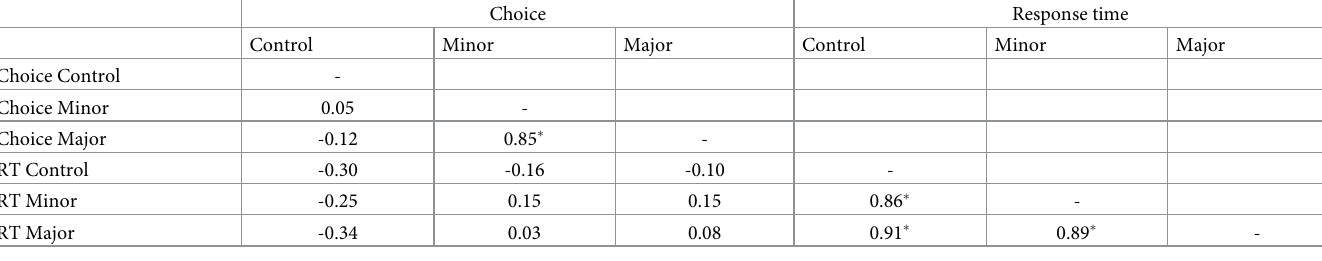
Table 2. Pearson correlations between choice and response time for control, minor violation, and major violation scenarios.